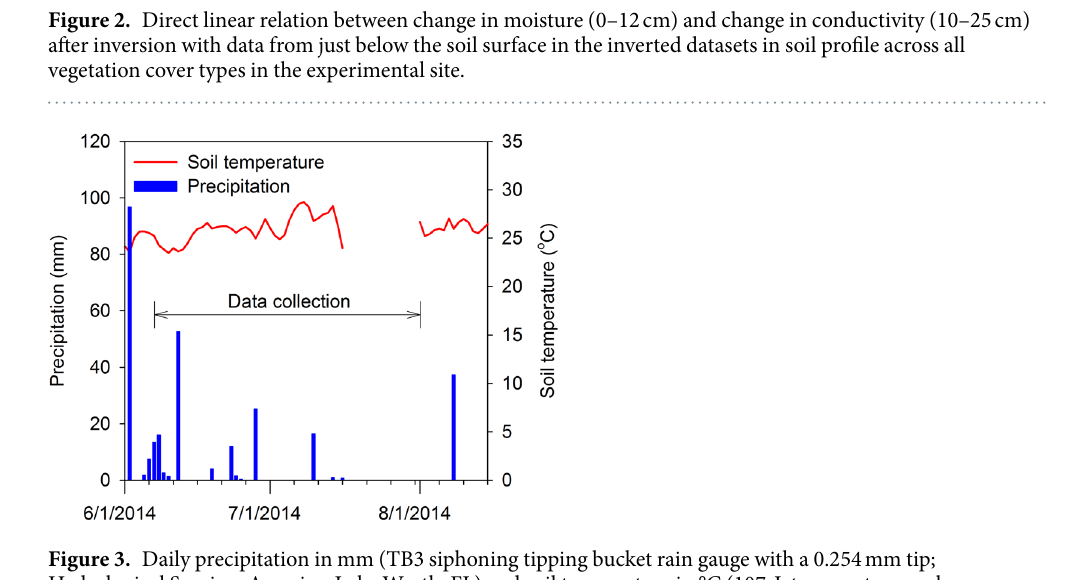
Figure 3. Daily precipitation in mm (TB3 siphoning tipping bucket rain gauge with a 0.254 mm tip; Hydrological Services America, Lake Worth, FL) and soil temperature in °C (107-L temperature probe; Campbell Scientific, Logan UT) from a weather station at Cross-Timber Range Research Station during June to August 2014. Soil temperature values at 5 cm depth are averaged over 5 minute and recorded. Horizontal arrow indicates the time of ERI data